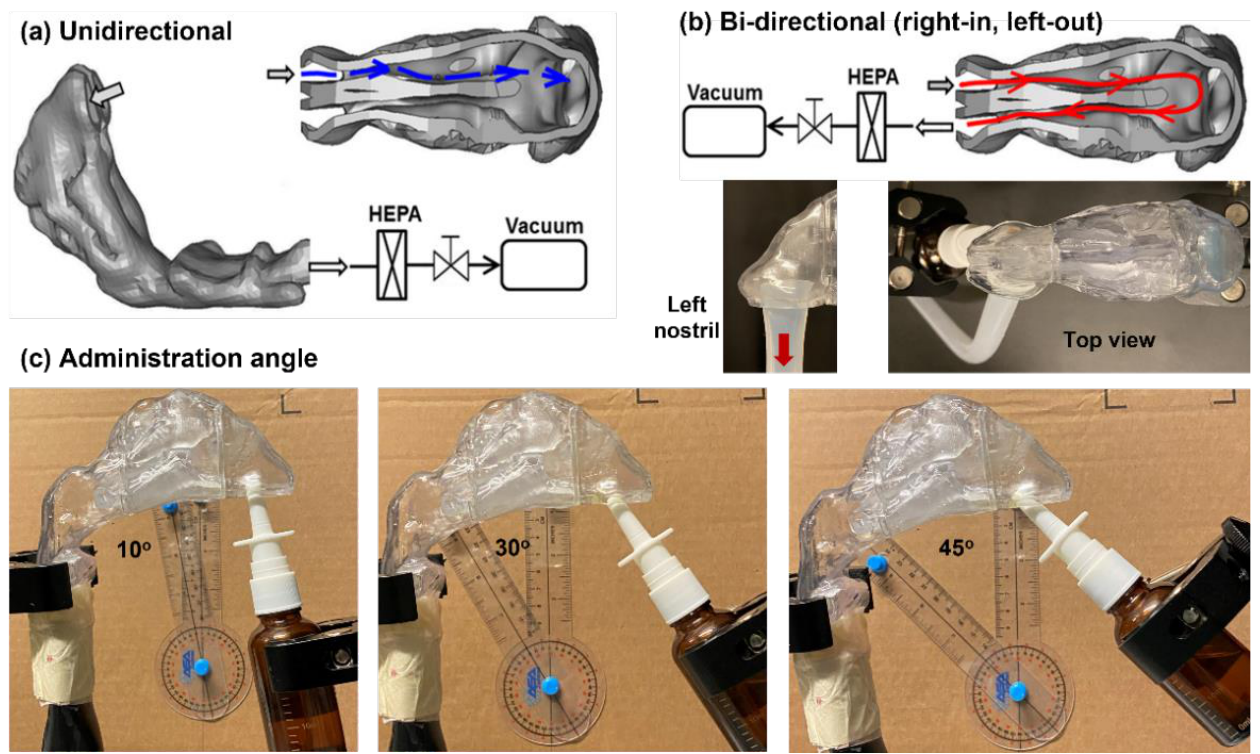
Figure 1. Nasal spray delivery diagram in ( a ) unidirectional mode, ( b ) bidirectional mode, and ( c ) administration angle to the right nostril: 10°, 30°, and 45°. To quantify the regional doses, the nasal cavity was divided into three parts: front nose, turbinate, and nasopharynx.